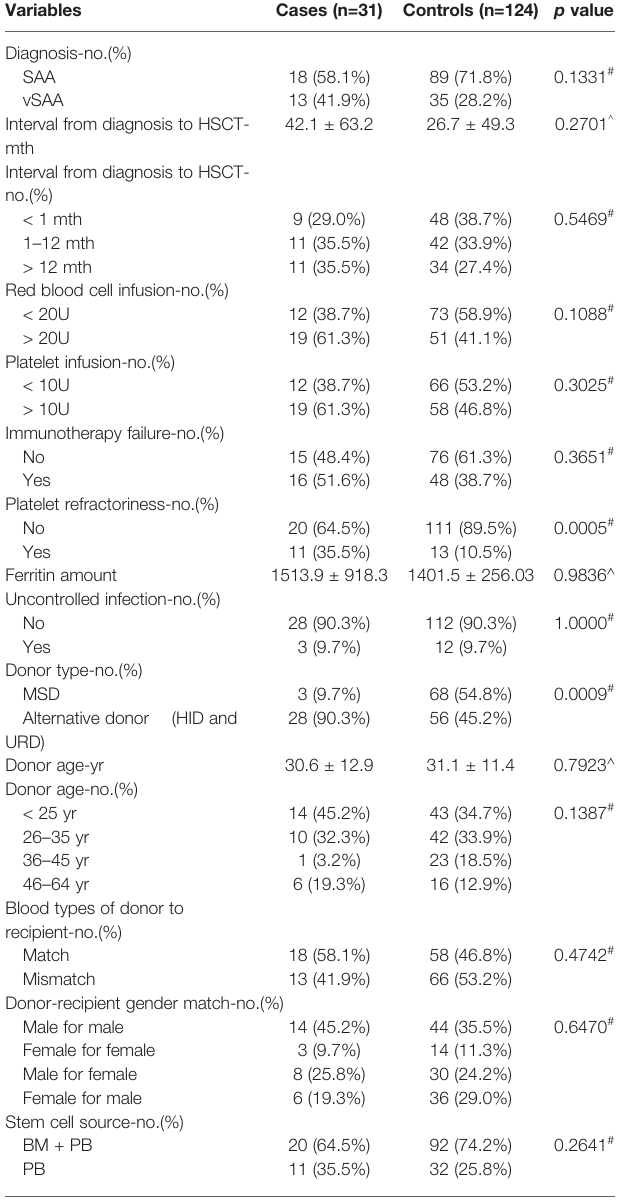
TABLE 2 | Comparison of 13 pre-transplant parameters between CMVR cases and age- and gender-matched controls. Variables